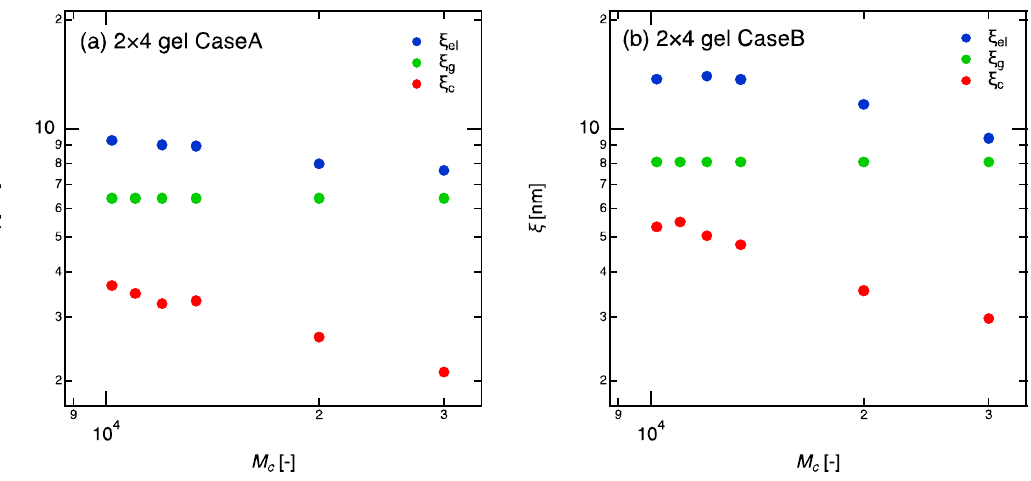
Figure 5. Various blob sizes of 2 × 4 gels as a function of molecular weight between crosslinkers ( M c ). ( a ) Case A: complete network; ( b ) Case B: incomplete network. The values in horizontal axis are the molecular weights of the chain between crosslinkers.